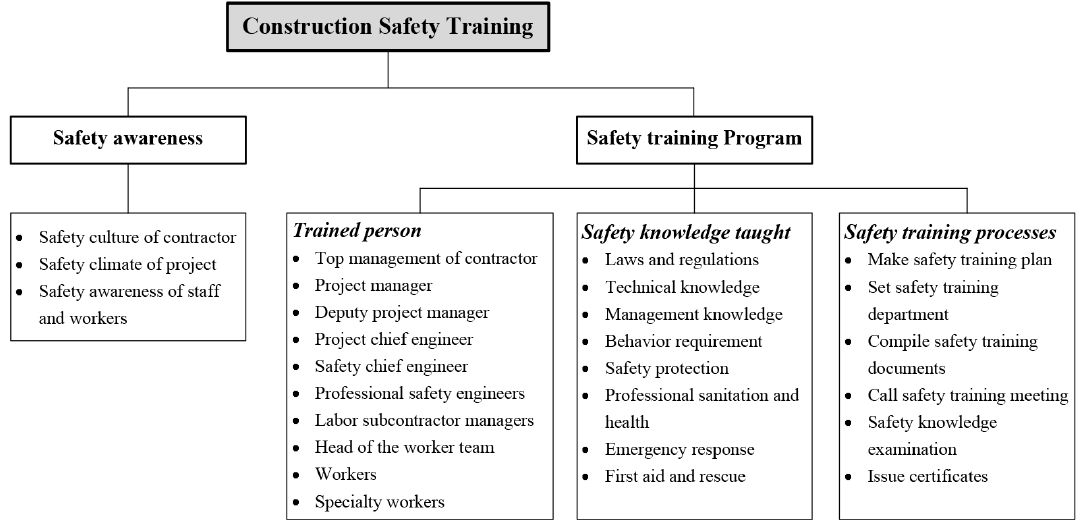
Figure 5. Structure of the safety training subsystem